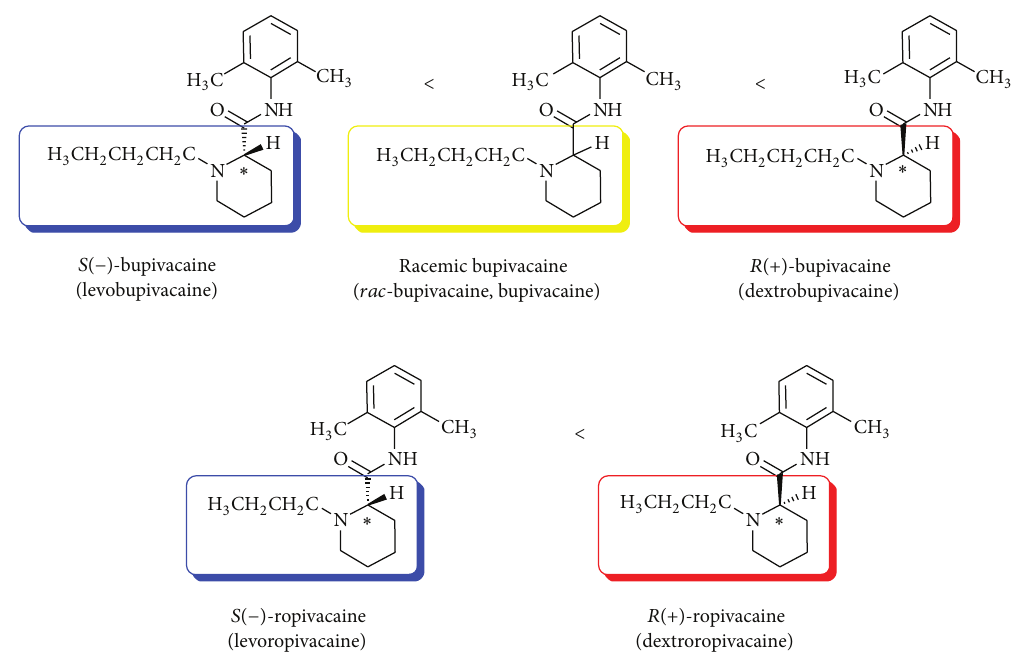
Figure 5: Local anesthetic stereoisomers and their relative